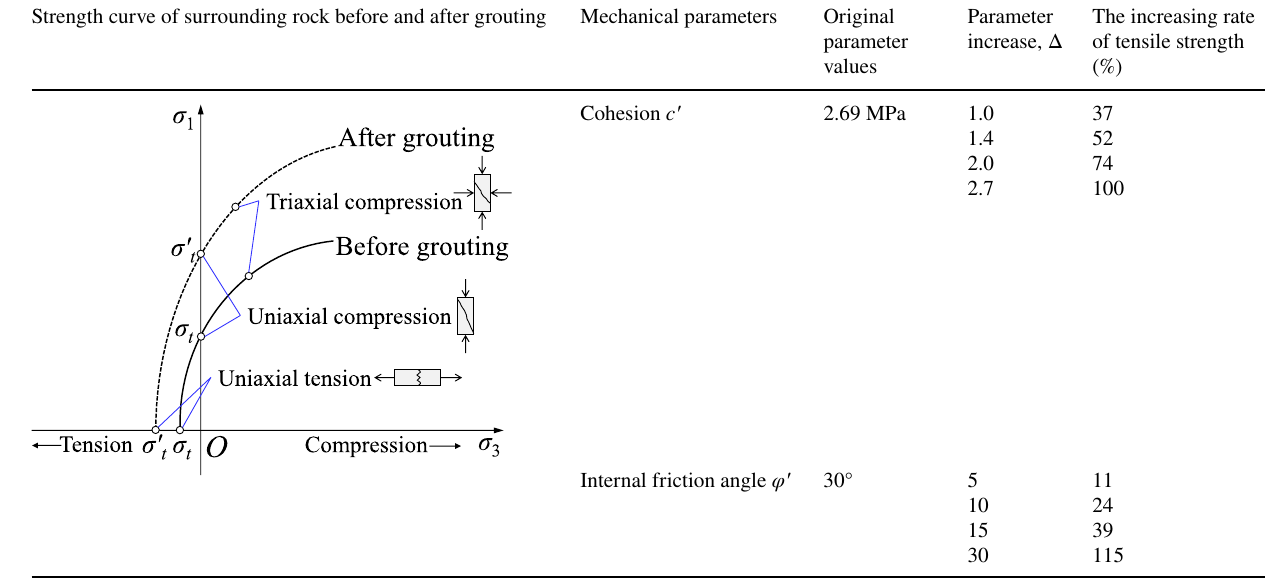
Table 3 Change in mechanical parameters of surrounding rock after grouting Strength curve of surrounding rock before and after